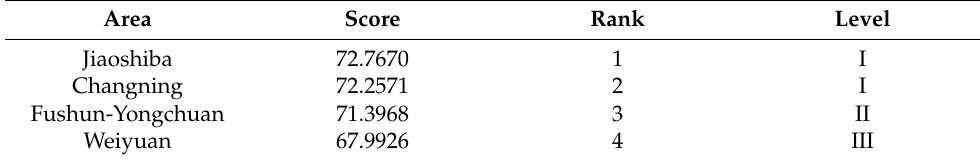
Table 7. Results of grading and classification of four regional sequence analysis methods. Area